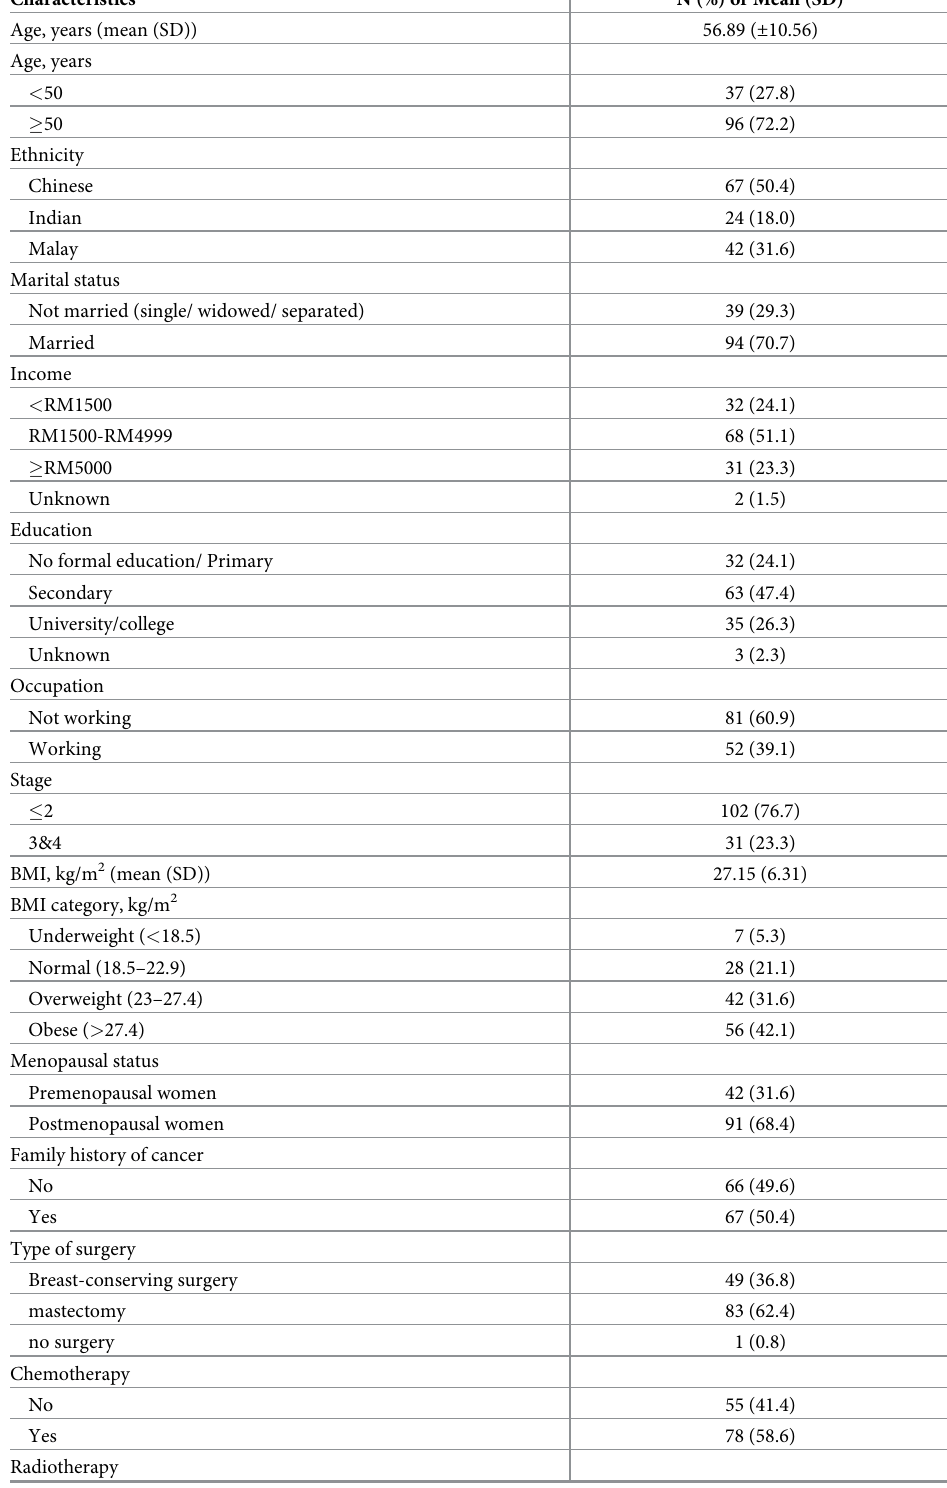
Table 1. Background characteristics of the patients at baseline, n =